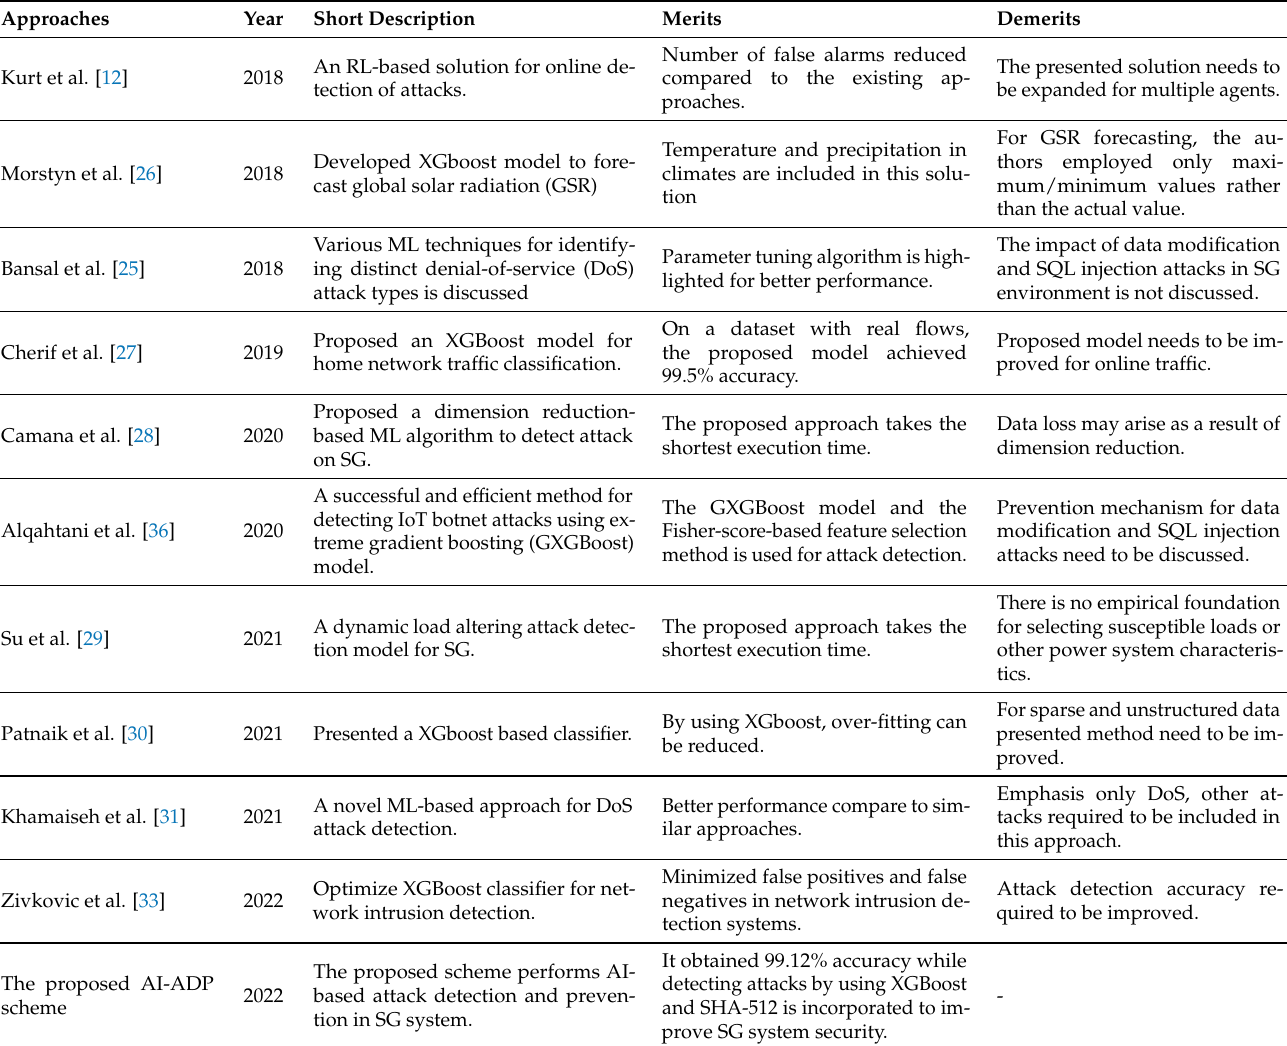
Table 2. A comparative analysis of the proposed AI-ADP scheme with the existing